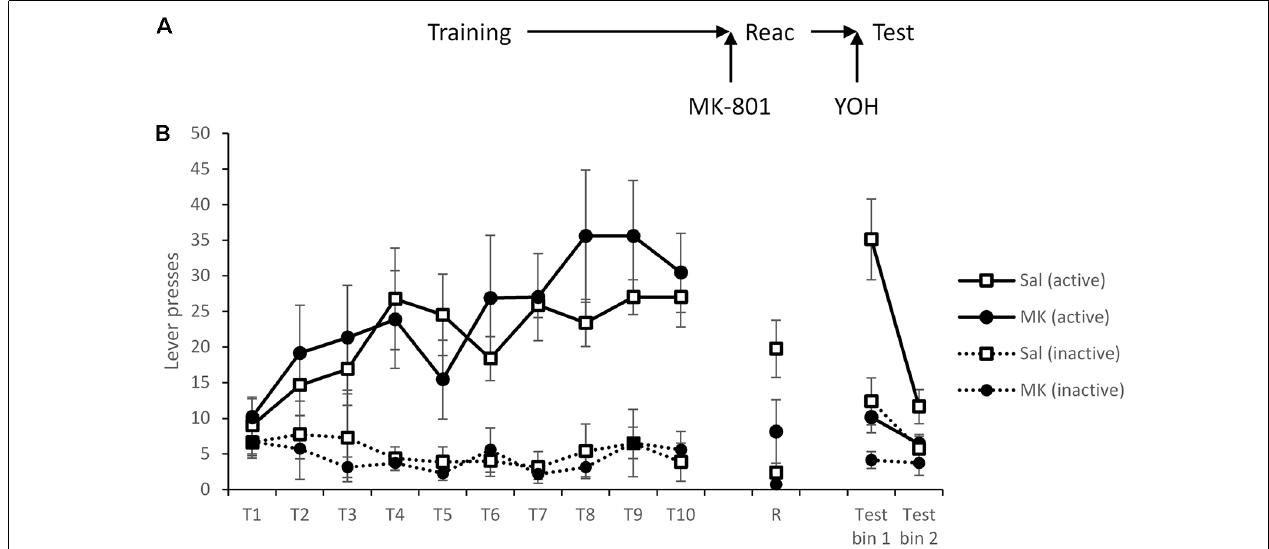
FIGURE 3 | Induction of stress using the α 2 antagonist yohimbine failed to reinstate lever pressing following reconsolidation-disruption with MK-801. (A) Schematic of the experiment. (B) Rats learned to lever press for cocaine over training days 1–10 (T1–T10). At reactivation (R), overall lever pressing was acutely reduced by MK-801 ( n = 7) compared to saline controls ( n = 8), however, this was not specific to either lever. Thirty minutes prior to testing all rats were injected with yohimbine and tested in extinction (with no discrete stimuli present). Rats previously treated with MK-801 remained significantly impaired, suggesting stress is not sufficient to rescue performance following disruption of instrumental memory. Data is presented as summary mean ±